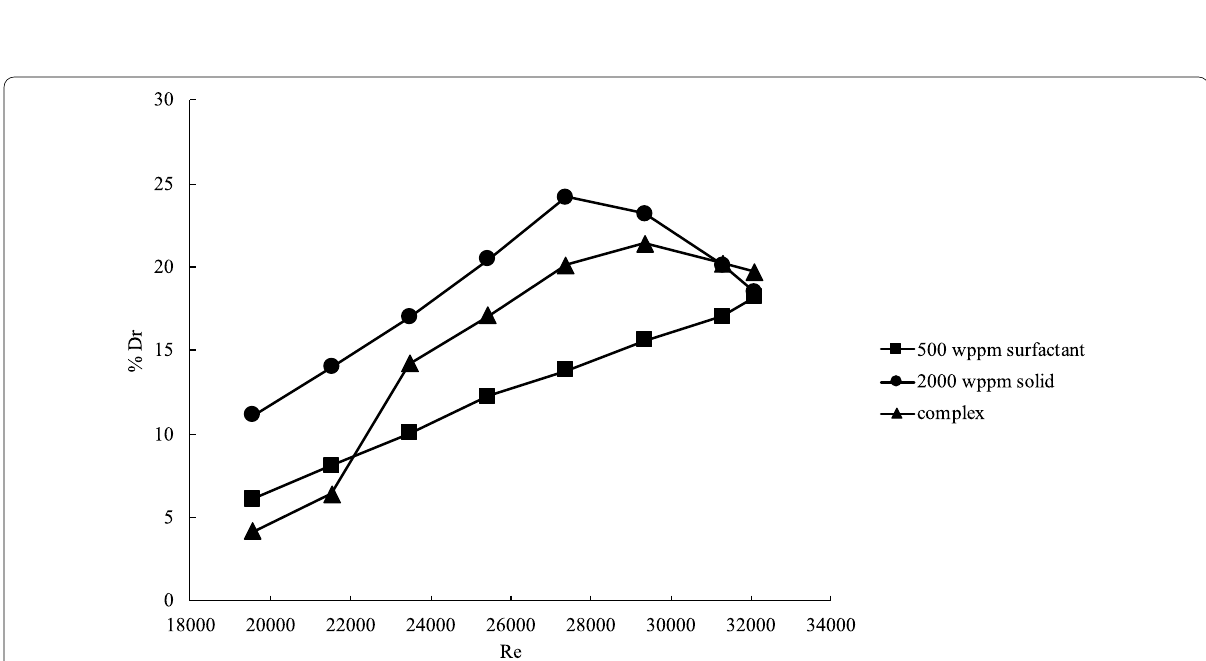
Fig. 9 Comparison between the 500 wppm surfactant solution %Dr with the 2000 wppm solid suspension and their